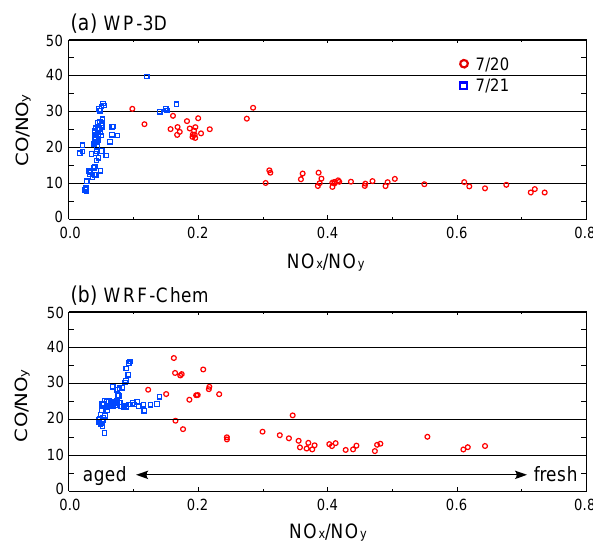
Fig. 14. CO/NO y versus NO x /NO y in (a) WP-3D measurements and (b) model simulation on 20 July (red open circles) and 21 July (blue open squares). Plume age is represented as a function of NO x /NO y